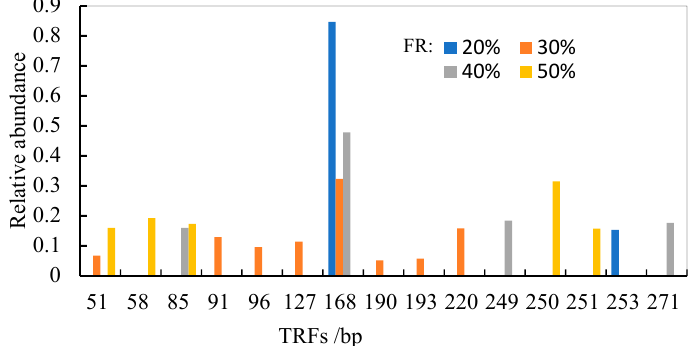
Figure 5. nosZ -based community structure at different FRs.